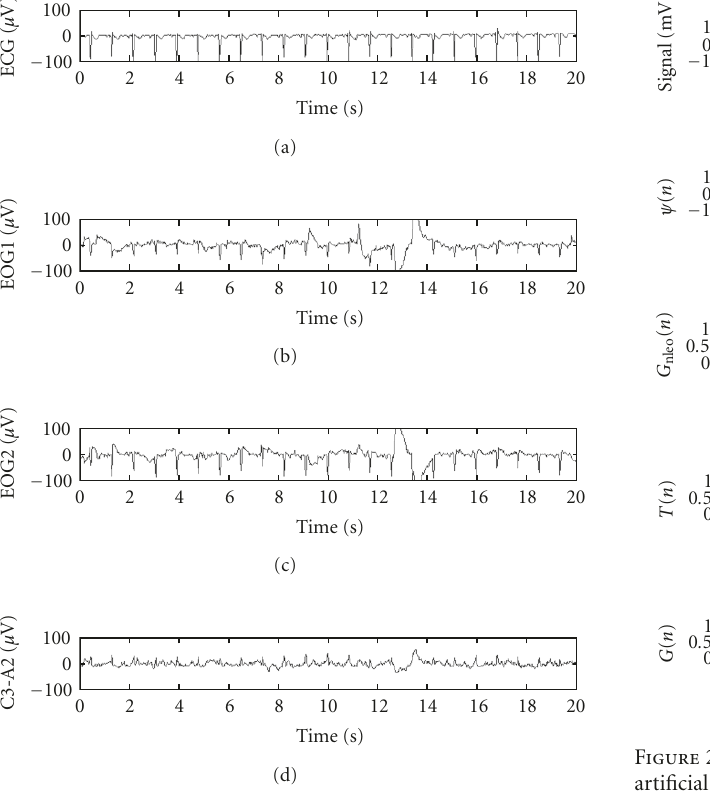
Figure 1: ECG artifact on EOG1, EOG2, and C3-A2.